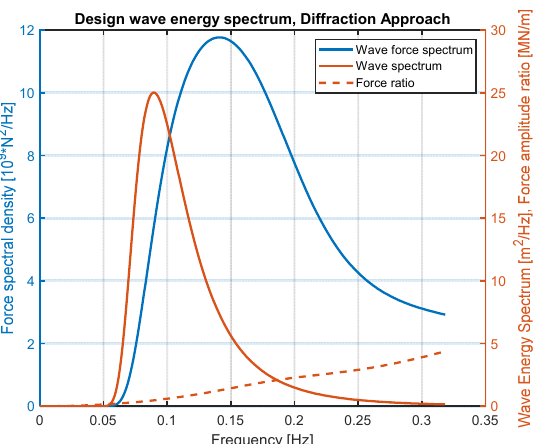
Figure 6. Wave spectrum, force ratio and wave energy spectrum (diffraction approach).